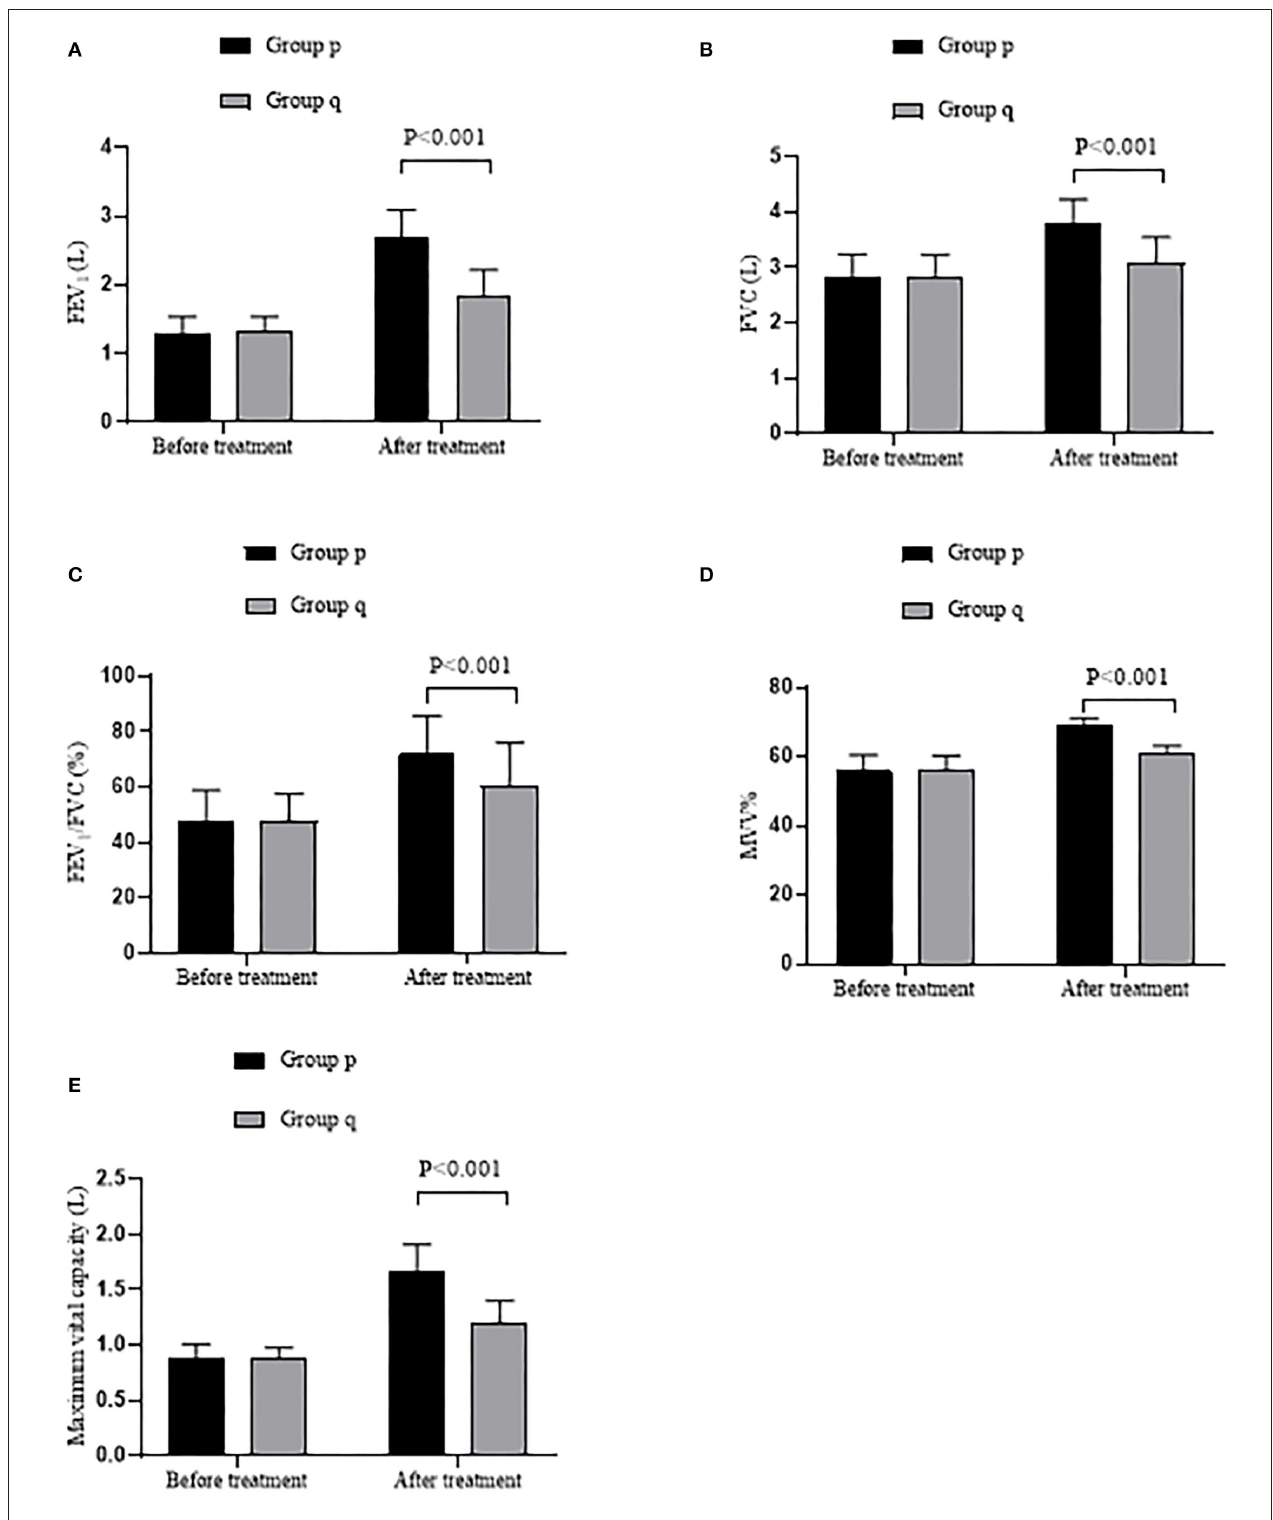
FIGURE 1 | Comparison of patients’ pulmonary function (x ± s). (A) showed the FEV 1 (L). (B) showed the FVC (L). (C) showed the FEV 1 /FVC (%). (D) showed the MVV%. (E) showed the maximal vital capacity (L).